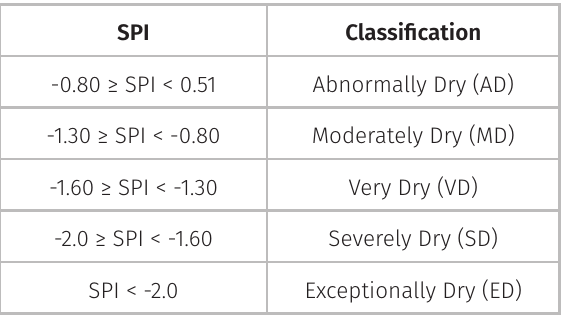
Table II. SPI classification (adapted from NOAA